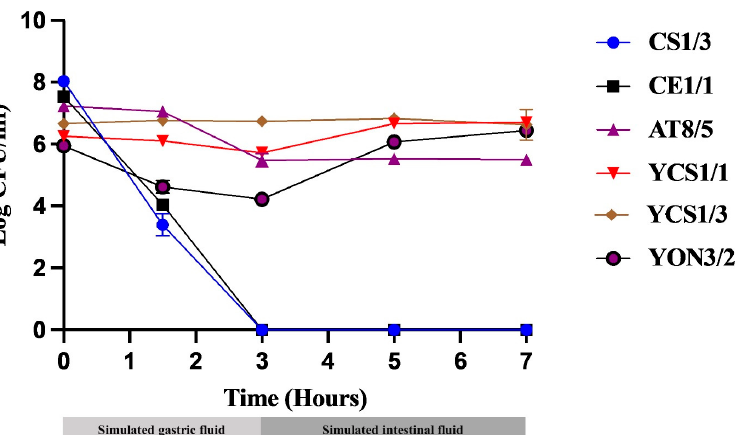
Figure 1. Testing probiotic tolerance in simulated GI tract conditions. Bacteria and yeasts isolated from fish GI tracts were determined for their probiotic activity by testing acid and bile tolerance in 3 h of simulated gastric fluid (SGF) and, subsequently, 3 h in simulated intestinal fluid (SIF), respectively. Enumeration of each isolate was performed by serial plating on MRS and YM agar for bacteria and yeast, respectively under limited oxygen conditions.